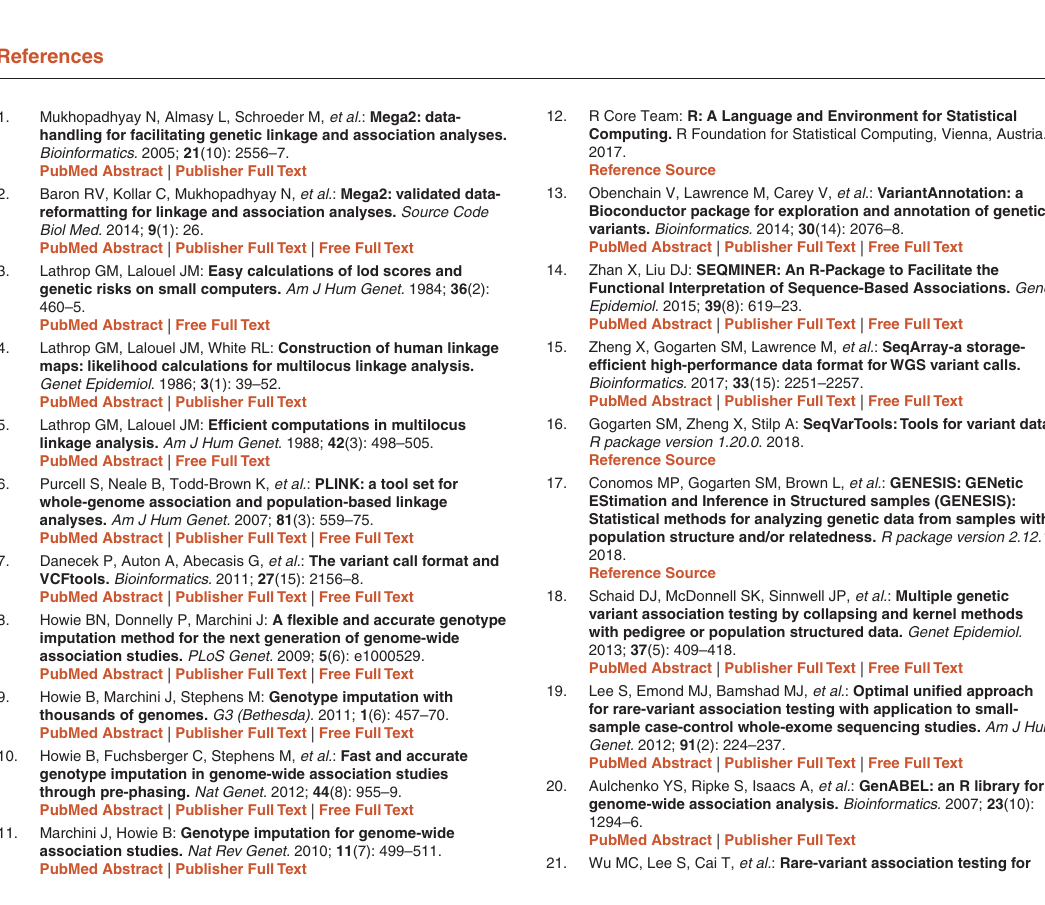
Supplementary File 1: The Mega2R package: R tools for accessing and processing genetic data in common formats. PDF contains detailed descriptions of the data frames that Mega2R makes available. Click here to access the